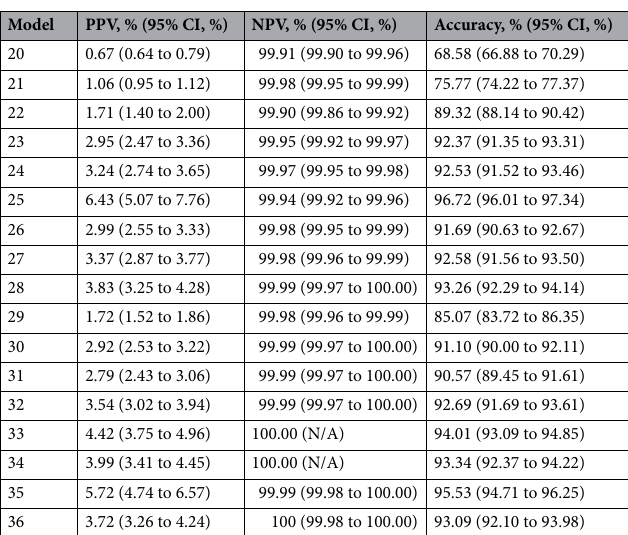
Table 4. Effects of prevalence on screening performance of each model: South Korea (prevalence, 0.27%). CI confidence interval, PPV positive predictive value, NPV negative predictive value, N/A not applicable.